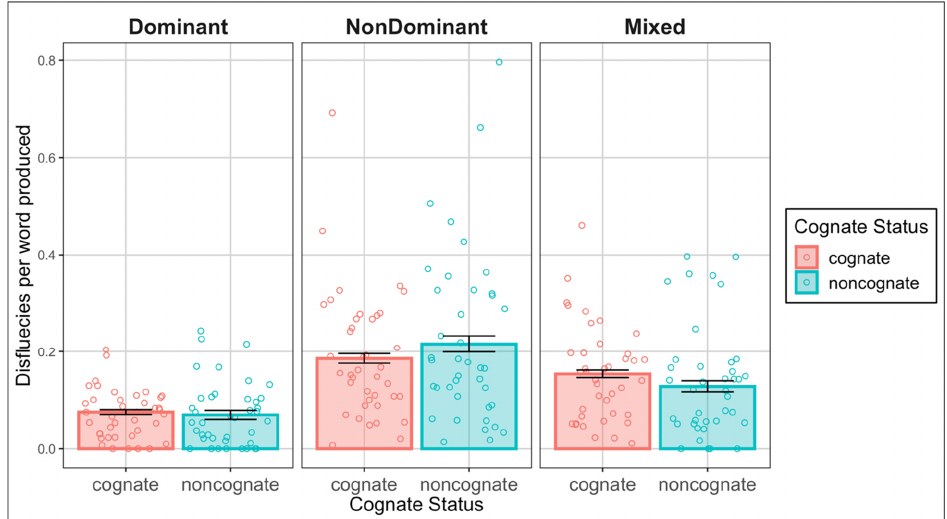
Figure 2. Average disfluencies per word by condition and cognate status with standard error bars. Data points are aggregated by participant.